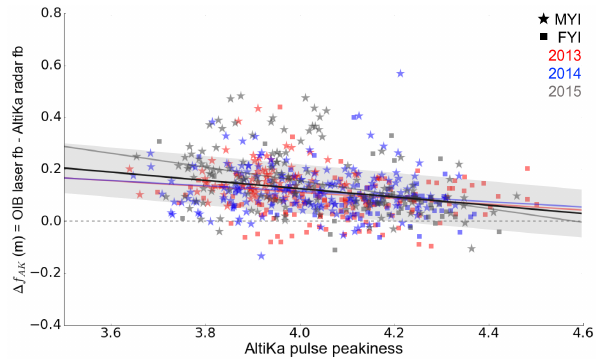
Figure 2. The value (cid:49)f CS , defined as the OIB theoretical radar freeboard minus the CS-2 radar freeboard, plotted against CS-2 pulse peakiness, for the OIB spring campaigns of 2013 (red), 2014 (blue), and 2015 (grey). Multi-year and first-year ice are plotted with stars and squares respectively, and the horizontal grey dashed line marks zero. The combined (all years) linear regression fit (CLRF), shown by the black line, has a slope of 0.06 and an inter- cept of − 0 . 46. The shaded area around the CLRF shows the 68% prediction interval, corresponding to a standard error (SE) on (cid:49)f CS of 8.4cm. Please note that fb is